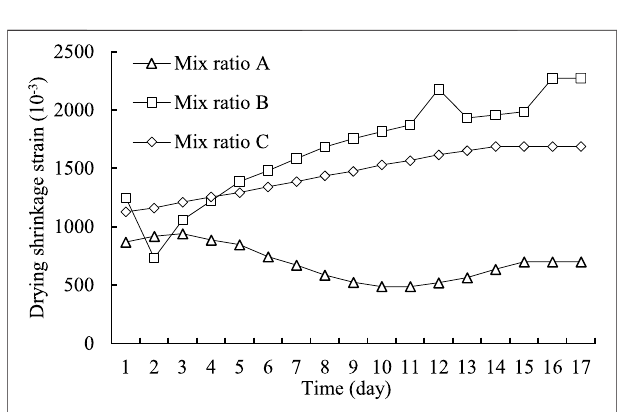
FIGURE 7 | Relationship between the drying shrinkage parameter and